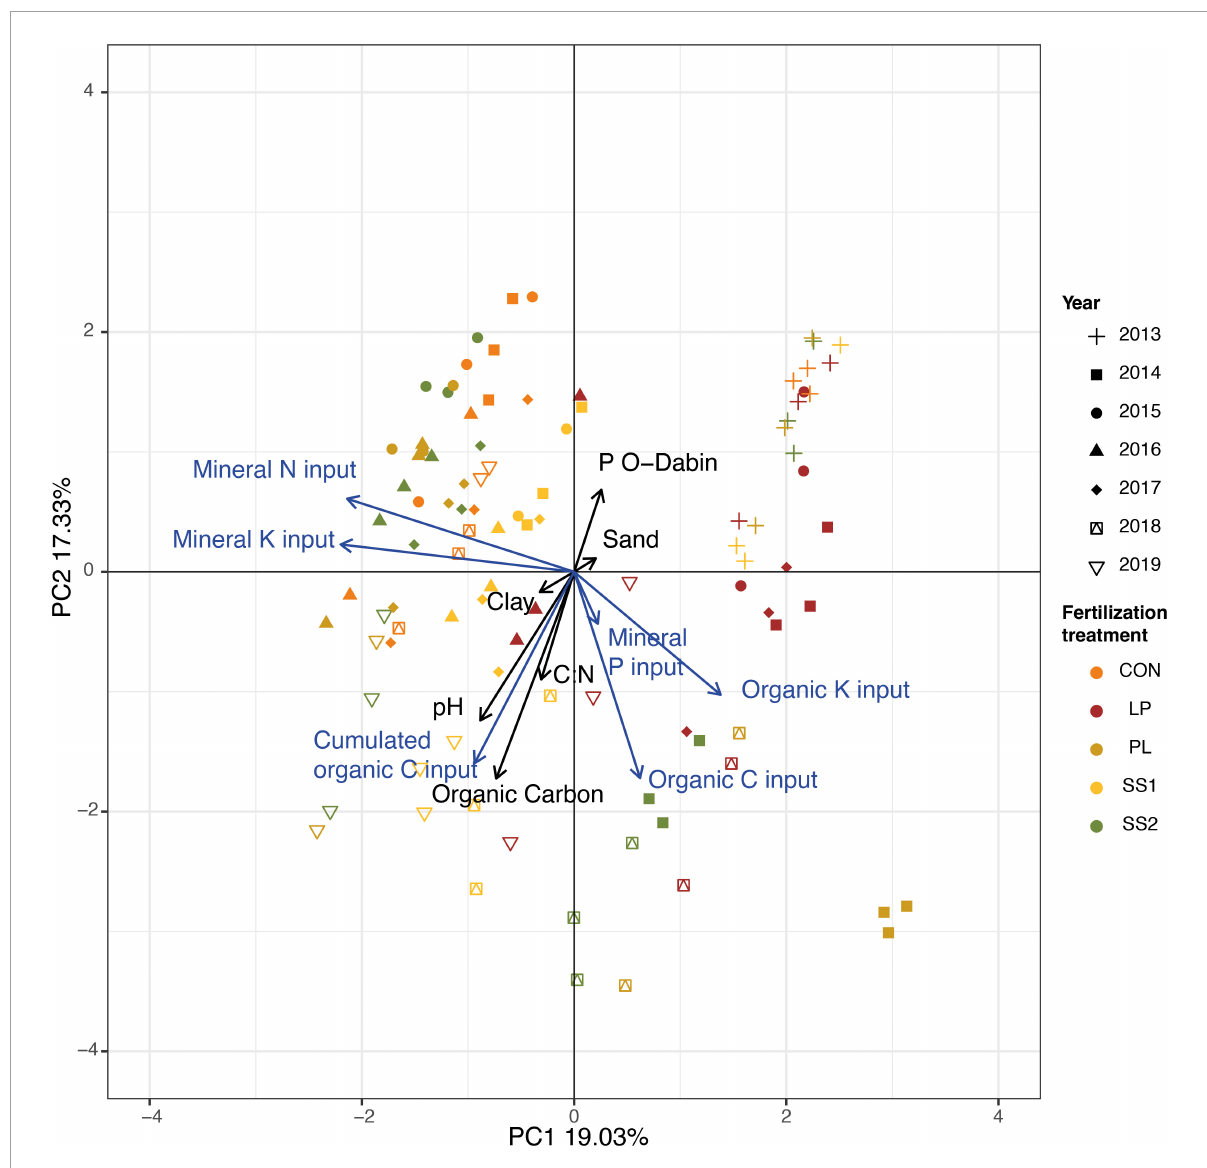
FIGURE1 Principal component analysis of the soil physico-chemical characteristics and fertilization practices in the experimental site of La Mare (Reunion Island) fertilized solely with inorganic fertilizer (control, CON), or fertilized with four different organic materials (SS1 and SS2, sewage sludge inputs; LP, liquid pig manure; PL, poultry litter). Discrimination between treatments, years or treatments x years was tested using a Monte Carlo permutation test (1,000 permutations). The black arrows are the soil physico-chemical characteristics, and the blue are the fertilizers physico-chemical